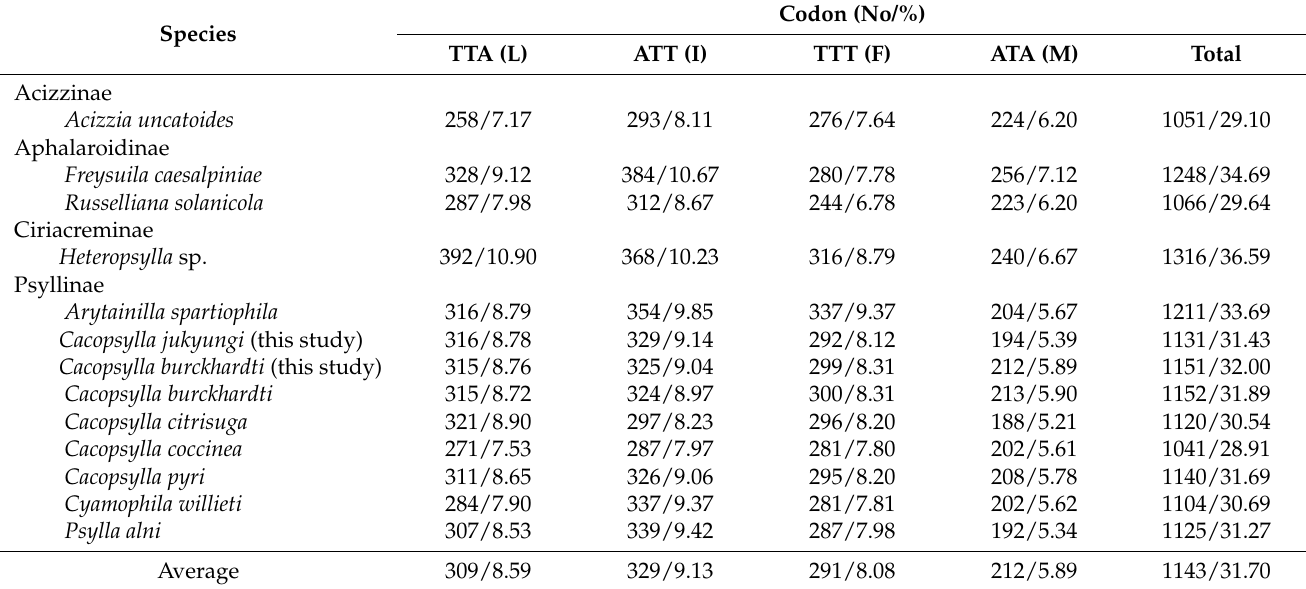
Table 3. Frequency of the four most common codons in